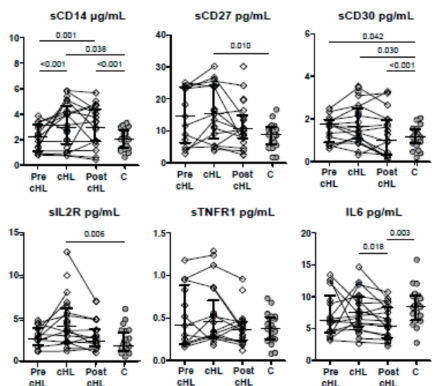
Figure 2. Cytokine concentration before cHL (pre-cHL), at cHL diagnosis (cHL) and post-chemotherapy (post-cHL), and in individuals with no cHL (Controls, C). Paired-samples are represented by continuous lines. Only significant p < 0.05 values are shown (Mann-Whitney U